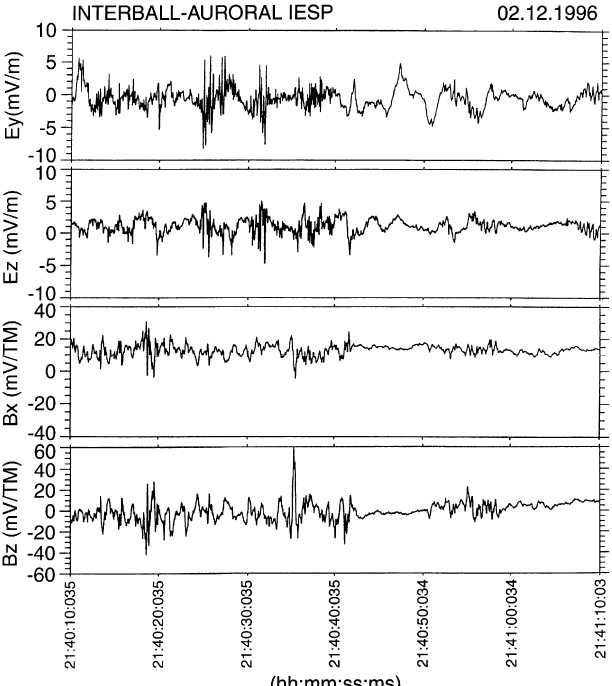
Fig. 8a–c. Marginal stability contours for the current-driven electro- static and electromagnetic ion cyclotron instabilities. In abscissa, (cid:98) ordinate the relative drift velocity between ions and electrons normalized to the Alfve´ n velocity. a ES and EM modes without addition of heavy ions; thin lines are the extrapolation of the corresponding curves; b and c for di(cid:128)erent O + concentrations: 0.1, 0.25, 0.4,